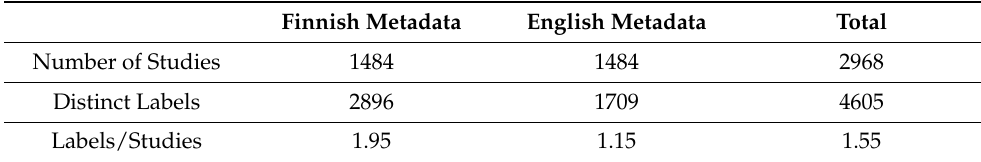
Table 1. Details of our snapshot of